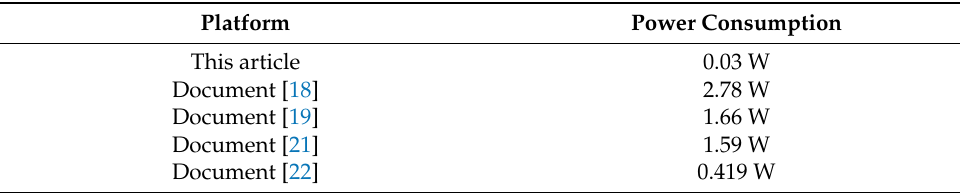
Table 4. Comparison of power consumption of CNN module